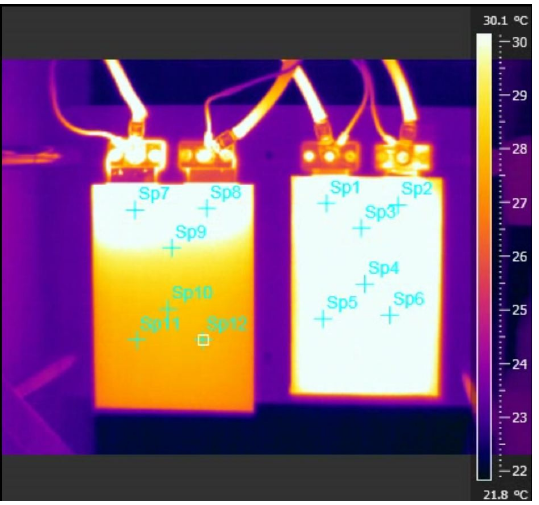
Figure 3. Surface temperature map attained using thermal imaging camera of: ( left ) a 20-A·h LiFePO pouch cell; and ( right ) a 20-A·h LiNiCoMnO 4